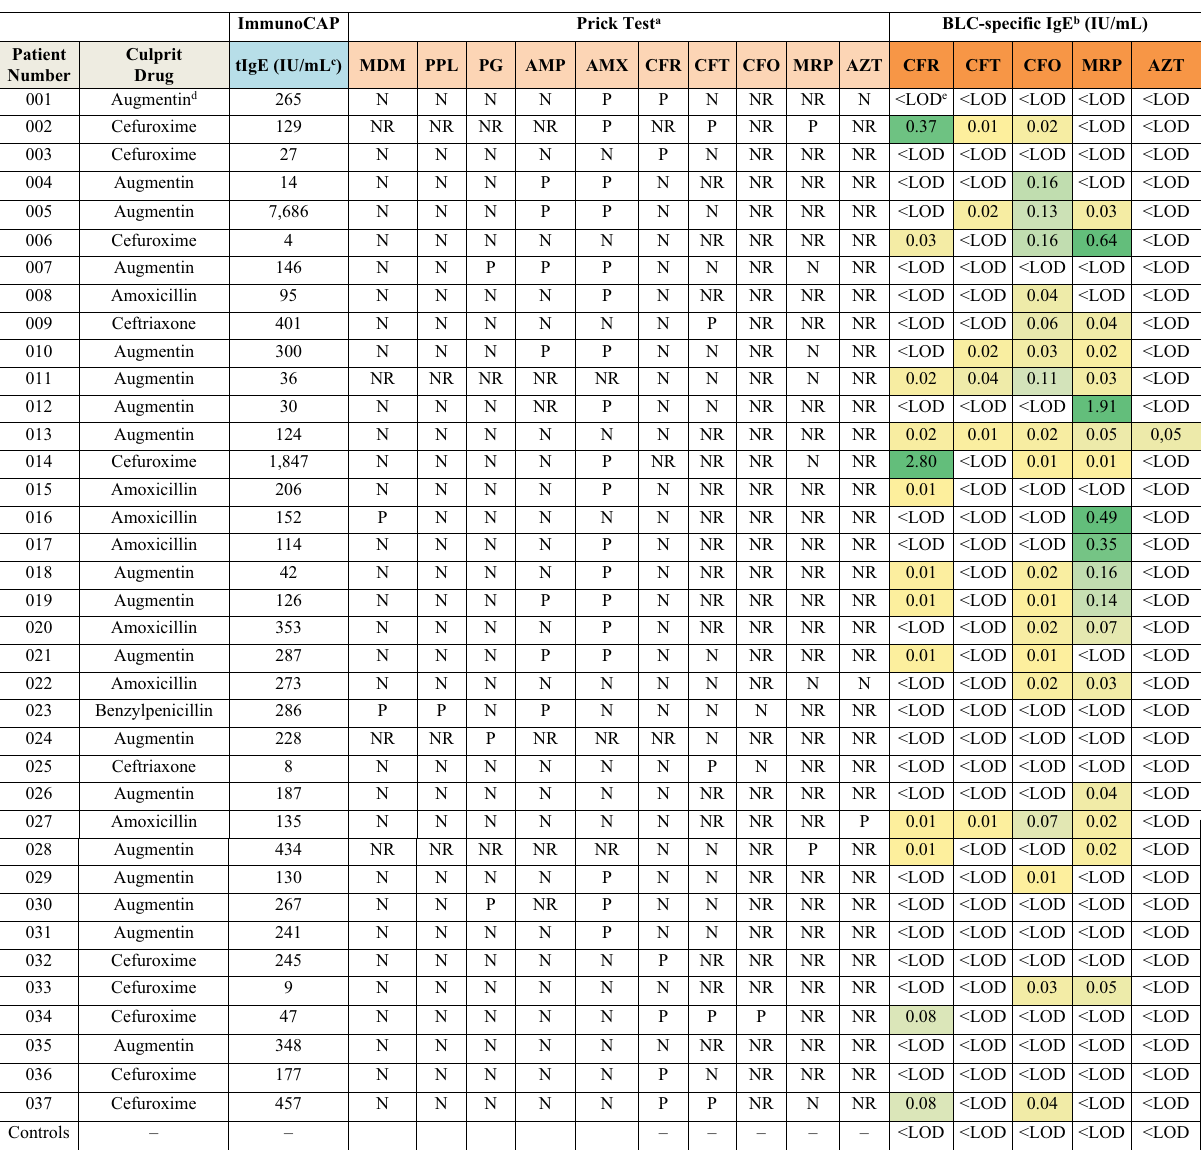
Table 2. Results of analysing the human serum samples by in vivo (prick test) and in vitro (multiplex DVD assay) tests. MDM minor determinants mixture (benzylpenicillin, sodium benzylpenicilloate and aztreonam. Immunoassay values are the mean of three replicates. Relative standard deviation (RSD) ranged from 4 to 13%. a P Positive, N Negative, NR Not reported in the clinical history. b Multiplex-DVD assay